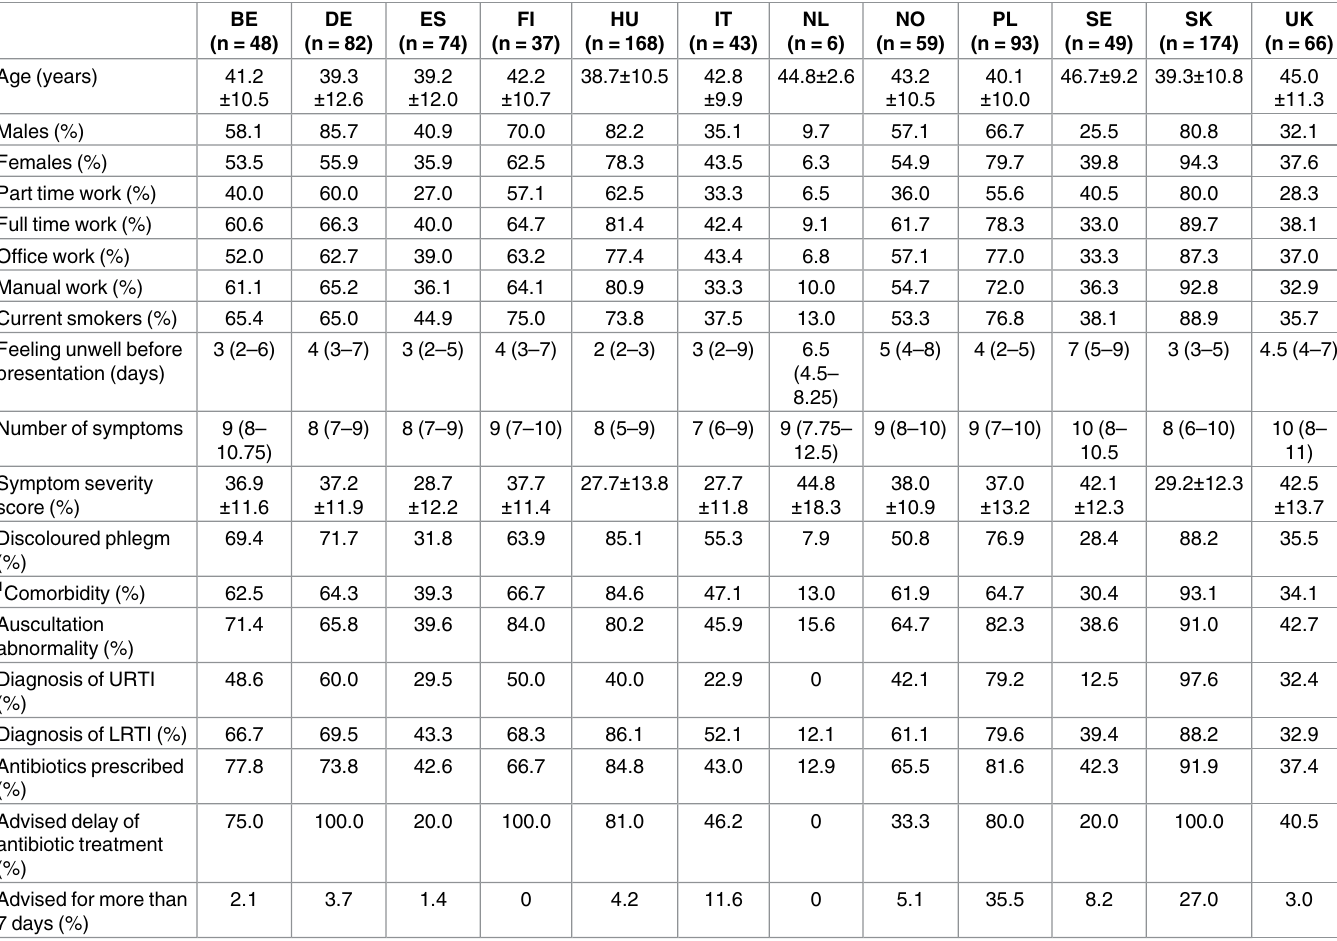
Table 2. Advice to take time off work according to patients’ characteristics by country of residence (network). BE—Belgium, DE—Germany, ES— Spain, FI—Finland, HU—Hungary, IT—Italy, NL—Netherlands, NO—Norway, PL—Poland,SE—Sweden, SK—Slovakia, UK—UnitedKingdom. Data were presented as mean ± SDor medianand interquartilerange (Q1-Q3) or percentage related to the total number of cases in particular subgroups